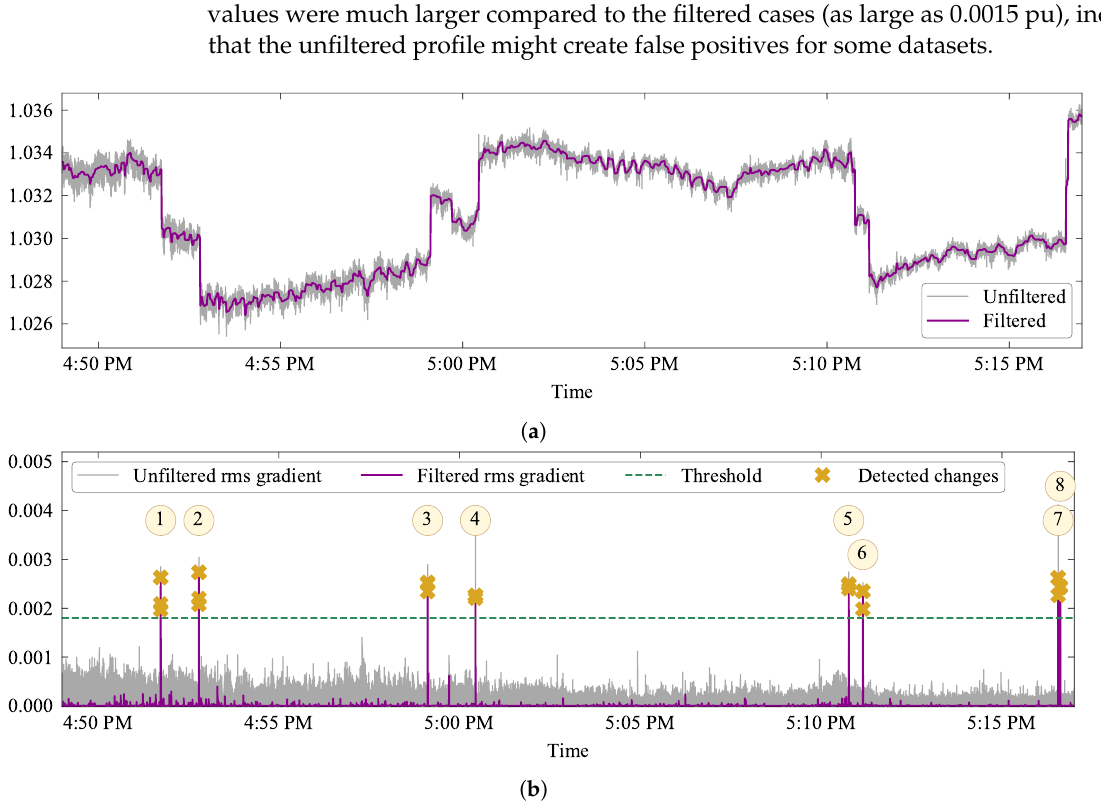
Figure 12. Results from the field data. ( a ) Unfiltered and filtered RMS voltage profiles; the filtered profile was obtained through total variation smoothing with δ = 0.0035. ( b ) Unfiltered and filtered RMS voltage gradient profiles, where the numbers in circles represent event